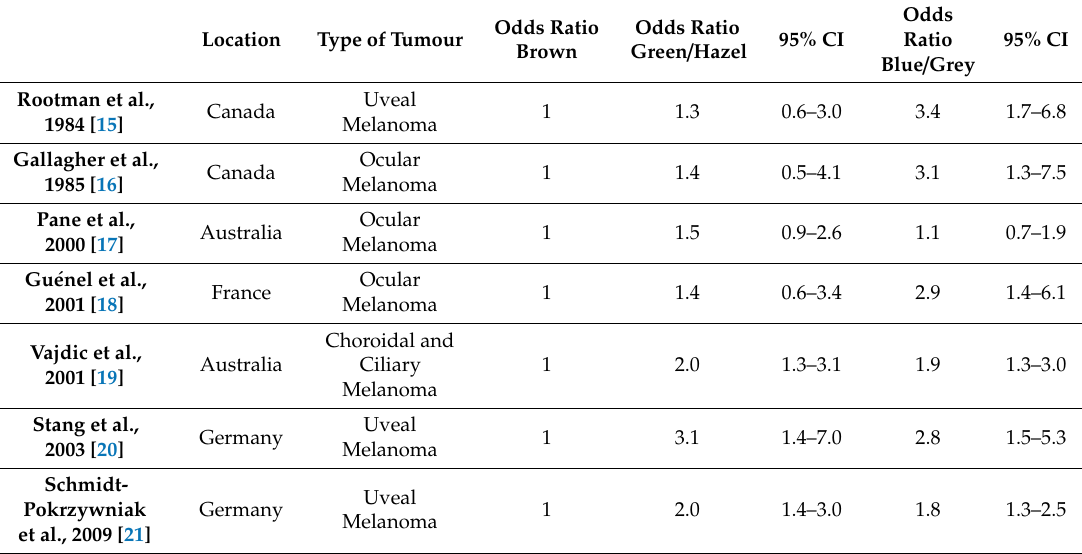
Table 3. Odds ratio to develop Uveal Melanoma in iris colour categories in other